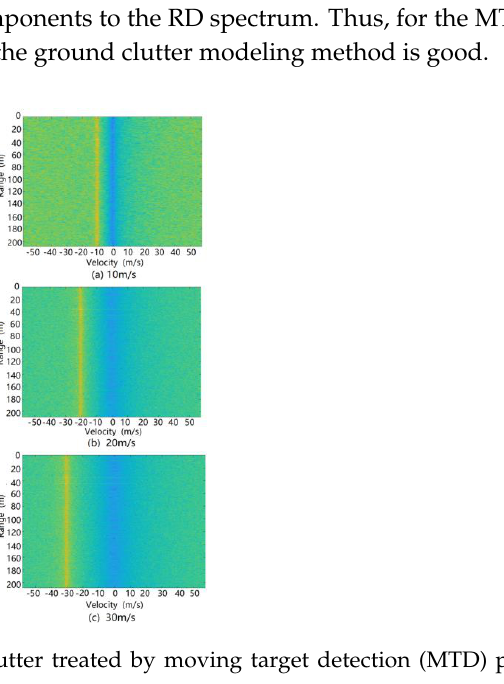
Figure 17. Position of stationary vehicle in RD spectrum of ground clutter during simulation.